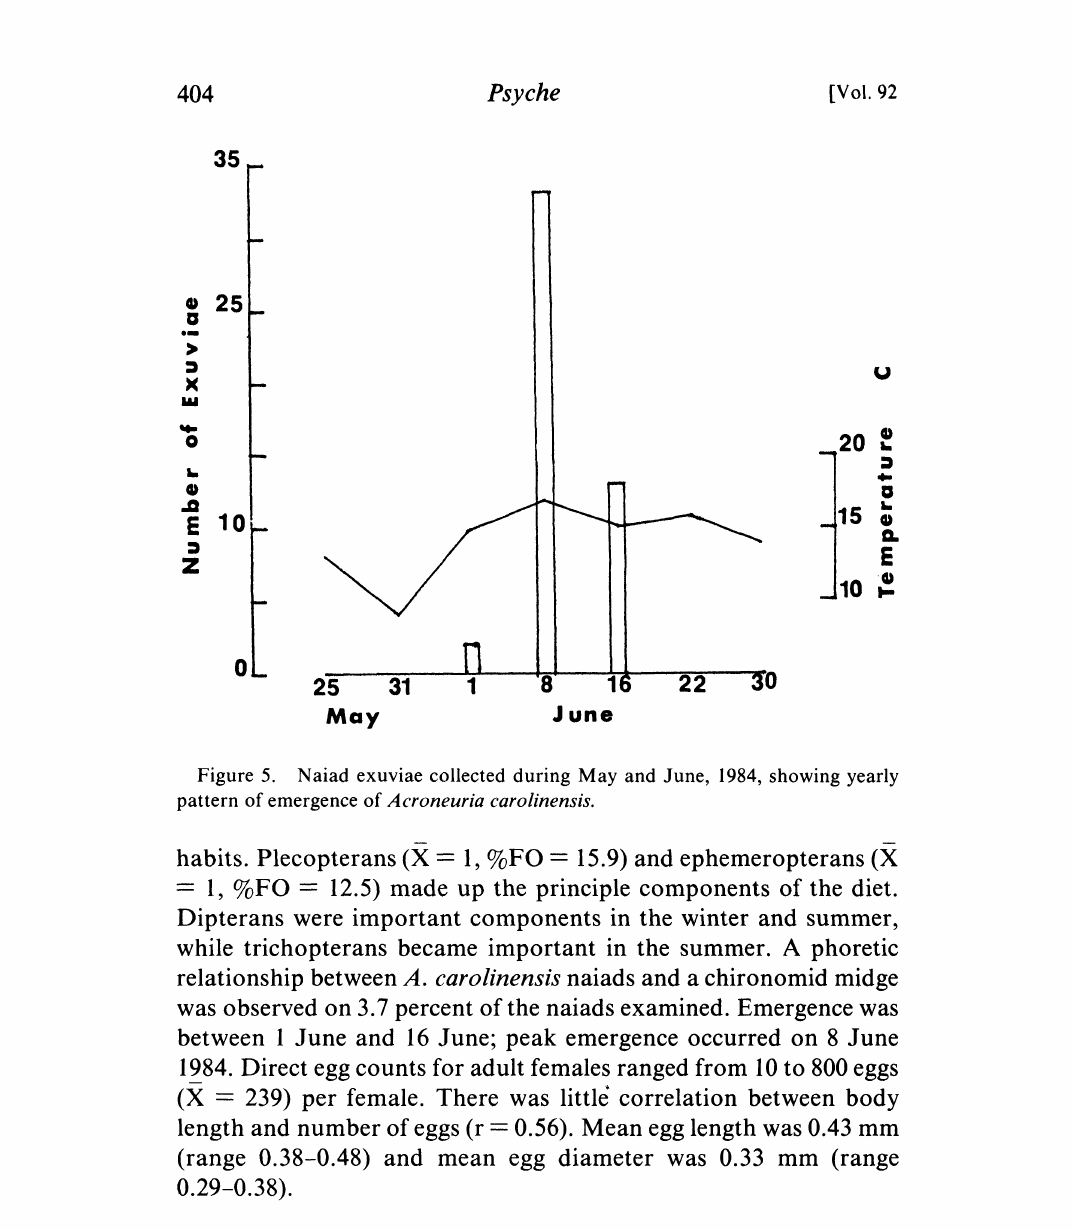
Figure 5. Naiad exuviae collected during May and June, 1984, showing yearly pattern of emergence of Acroneuria